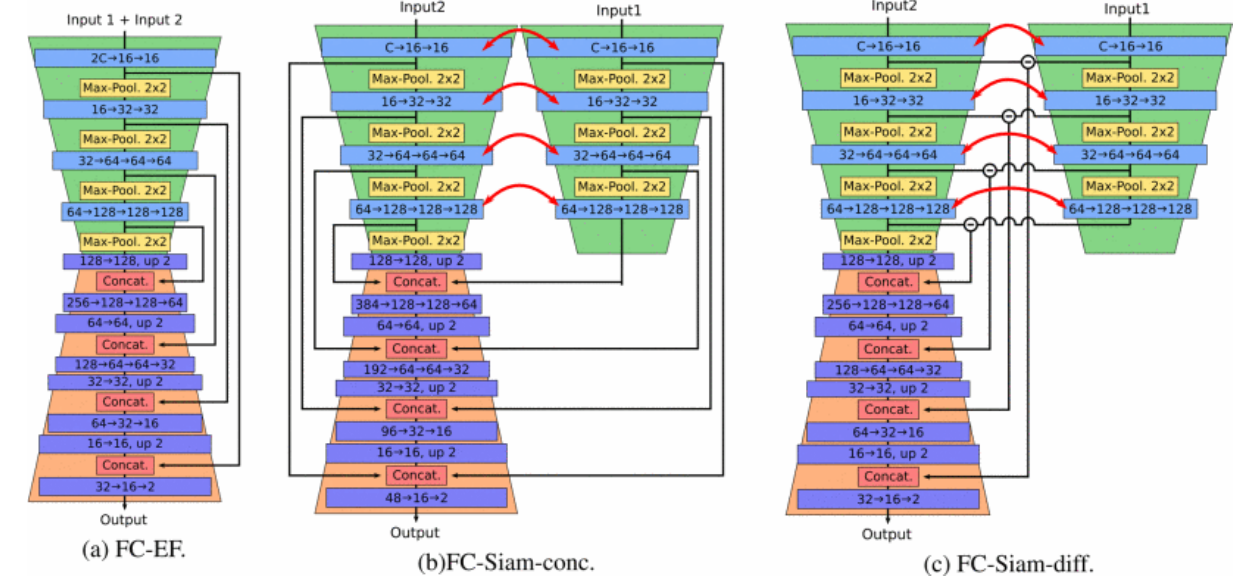
Figure 4. Schematics of the three architectures proposed by Caye Daudt et al. [64] for change de- tection. ( a ) Fully Connvolutional Early Fusion (FC-EF) network, which is a single-stream UNet-like network. ( b ) Fully Convolutional Siamese—Concatenation (FC-Siam-conc) and ( c ) Fully Convolu- tional Siamese—Difference (FC-Siam-diff) networks which are double-stream UNets. Block colour legend: blue is convolution, yellow is max pooling, red is concatenation, and purple is transpose convolution. Red arrows illustrate shared weights. Copyright © IEEE. All rights reserved. Reprinted with permission from Caye Daudt et al.